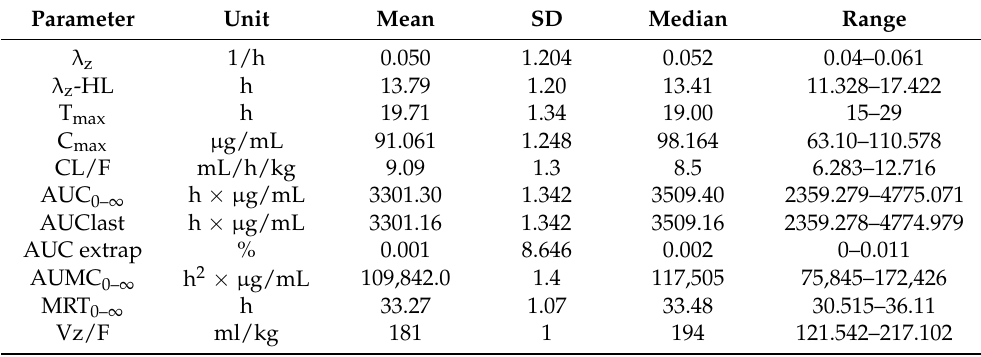
Table 3. Geometric mean plasma pharmacokinetic parameters of meloxicam following single oral administration at 30 mg/kg in lactating dairy cows ( n = 5).